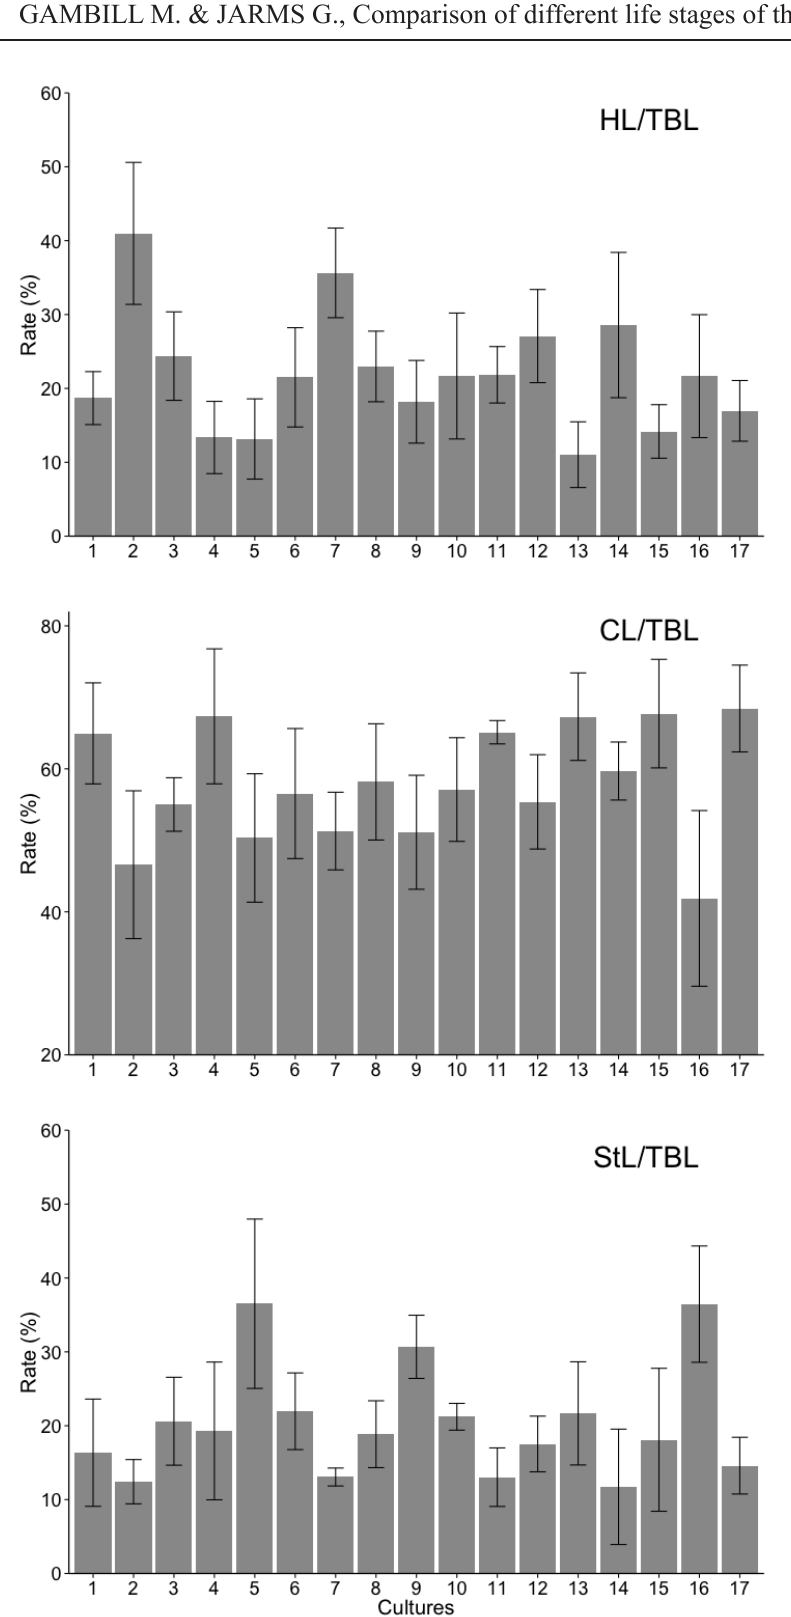
Fig. 2. Body proportions of polpys (shown as percentage). Error Bars show standard deviation. Abbreviations: see Table